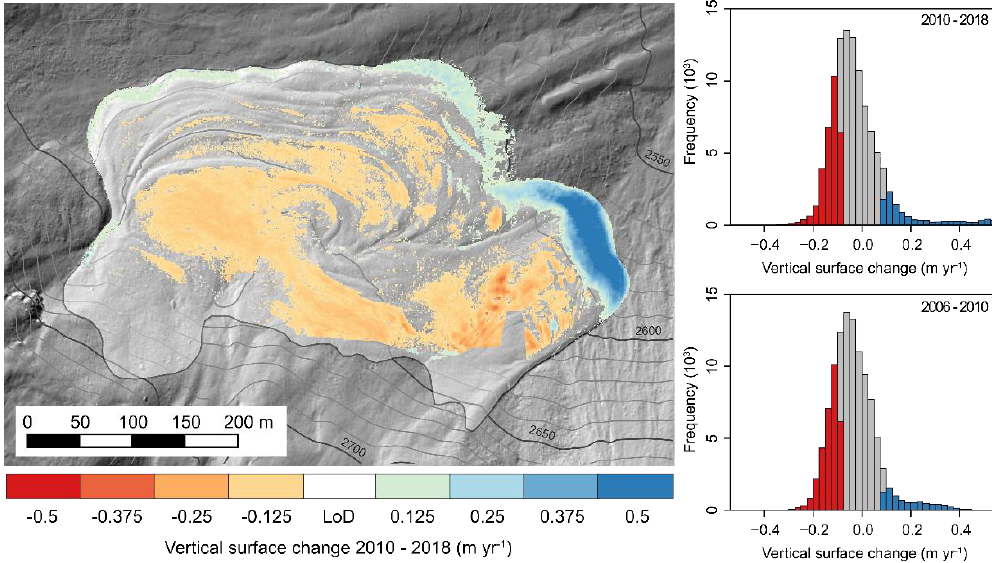
Figure 11. Vertical surface changes of the Kaiserberg rock glacier (RG12), illustrated as a DEM of Difference (DoD) between 2010 and 2018 (left panel) and its frequency distribution (upper-right panel). For comparison, changes between 2006 and 2010 are shown as well (lower-right panel). Most elevation gains can be attributed to the advance of the eastern rock glacier front, while areas of surface lowering indicate subsidence through permafrost degradation and extension-conditioned thinning.